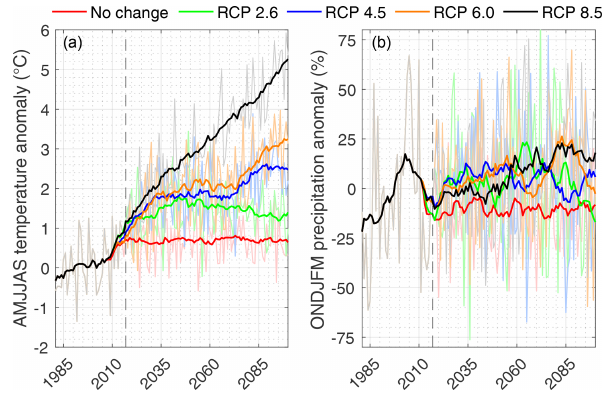
Figure 10. Projected future (a) AMJJAS temperature and (b) OND- JFM precipitation changes for Terskol, as compared to the 1981– 2010 reference, for different RCP scenarios until 2100CE. Thin coloured lines represent annual values; thicker lines represent 15- year moving means. The dashed vertical line represents the present (i.e. 2017, the most recent year of glaciological observations).